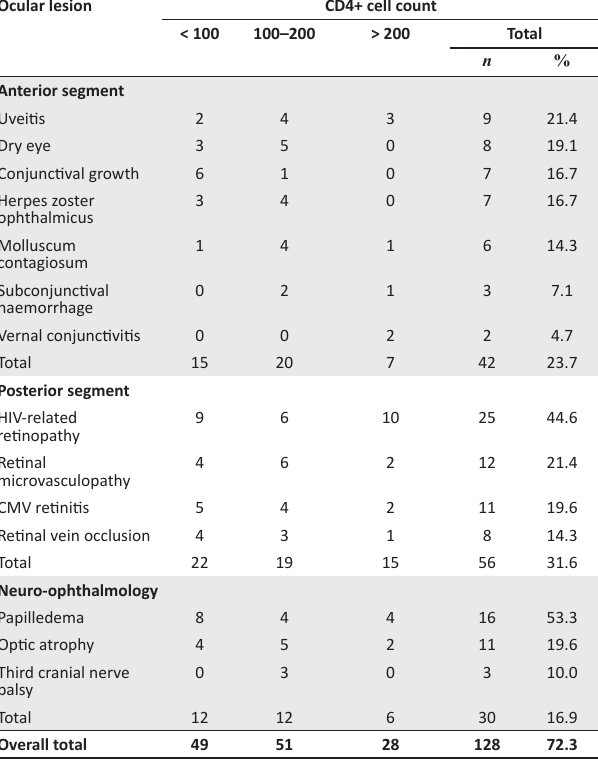
TABLE 8 : Association between ocular lesion and CD4+ cell count. Ocular